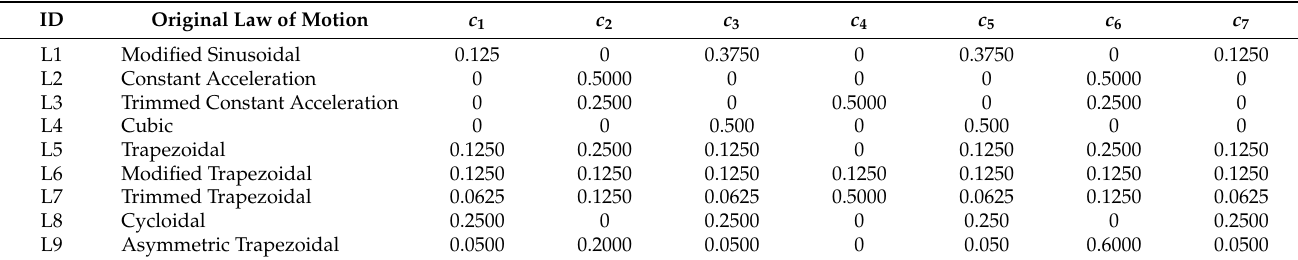
Table 3. Coefficients’ values of the laws of motion of the modified trapezoidal class used as the original law of motion.